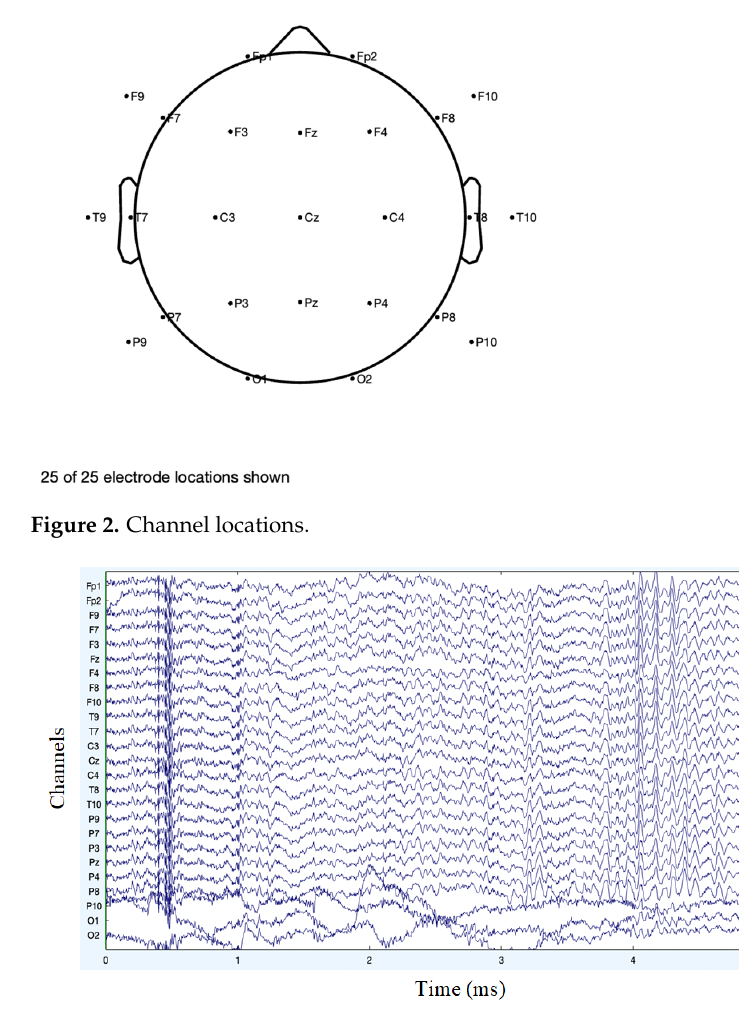
Figure 4. Topoplots of the independent components.